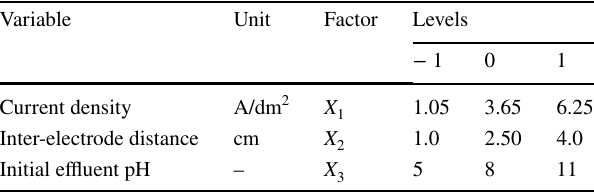
Table 1 Coded and actual values of the variables of the design of experiments for the electrocoagulation process Variable